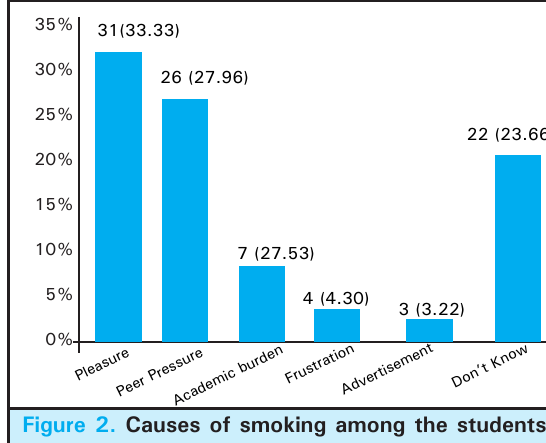
Figure 2. Causes of smoking among the students n